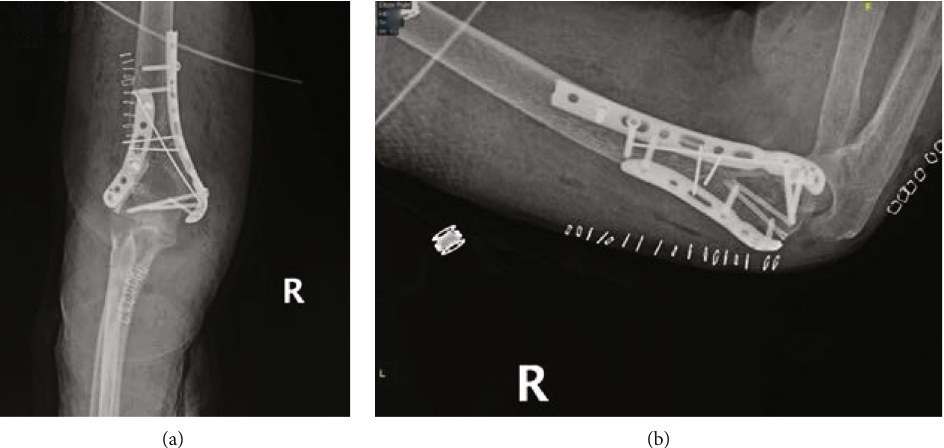
Figure 4: Postoperative plain radiographs of the right elbow showing on the (a) AP and (b) lateral views reduction of the medial and lateral epicondyles using double plating with ten screws.